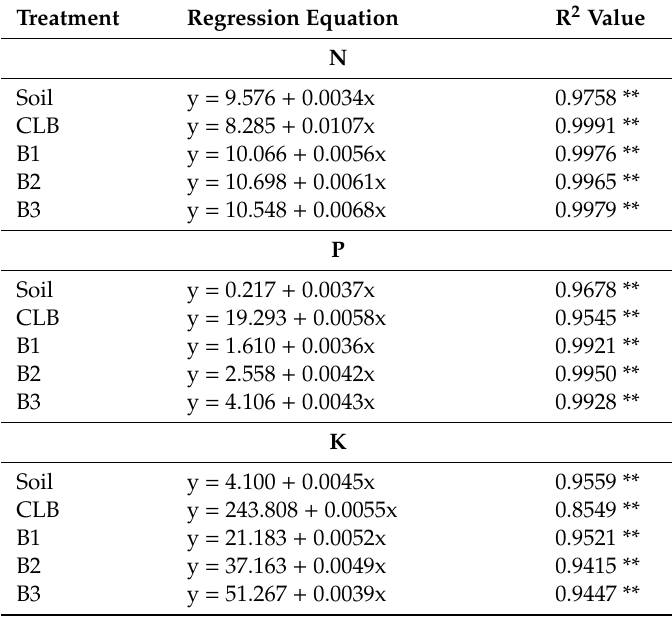
Table 20. Regression equations and R 2 values relating added nitrogen, phosphorus, and potassium as well as desorbed nitrogen, phosphorus, and potassium in treatments.